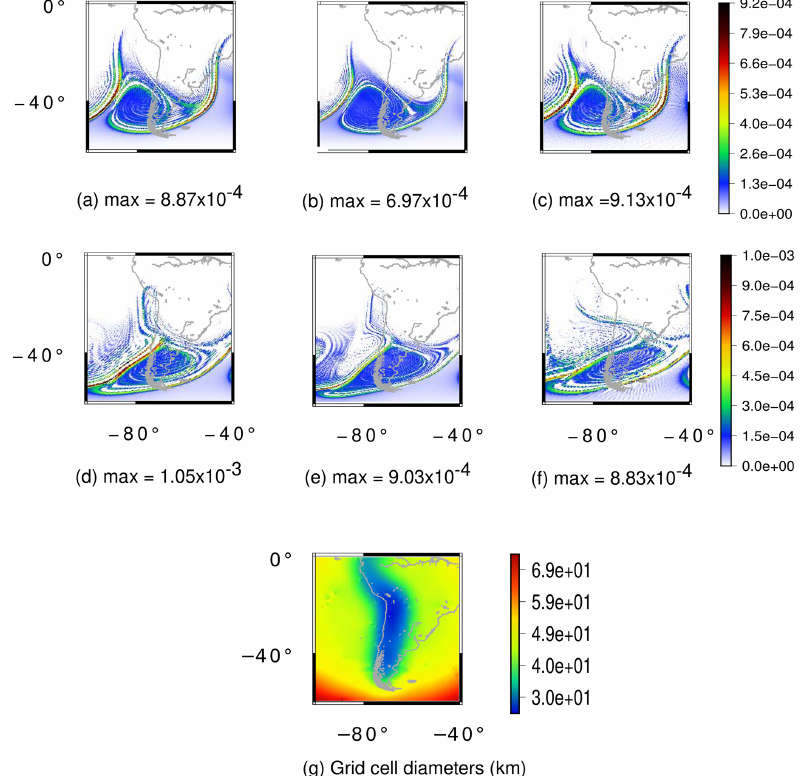
Figure 21. Unstable barotropic jet test case for the moist shallow-water model. (a–c) Cloud field at day 7 for the UR8, UR9 and VR7 grids, respectively. (d–f) Cloud field at day 8 for the UR8, UR9 and VR7 grids, respectively. (g) Grid cell diameters in kilometers for the VR7 grid. The UR8 and UR9 grids have an average resolution of 30 and 15km,